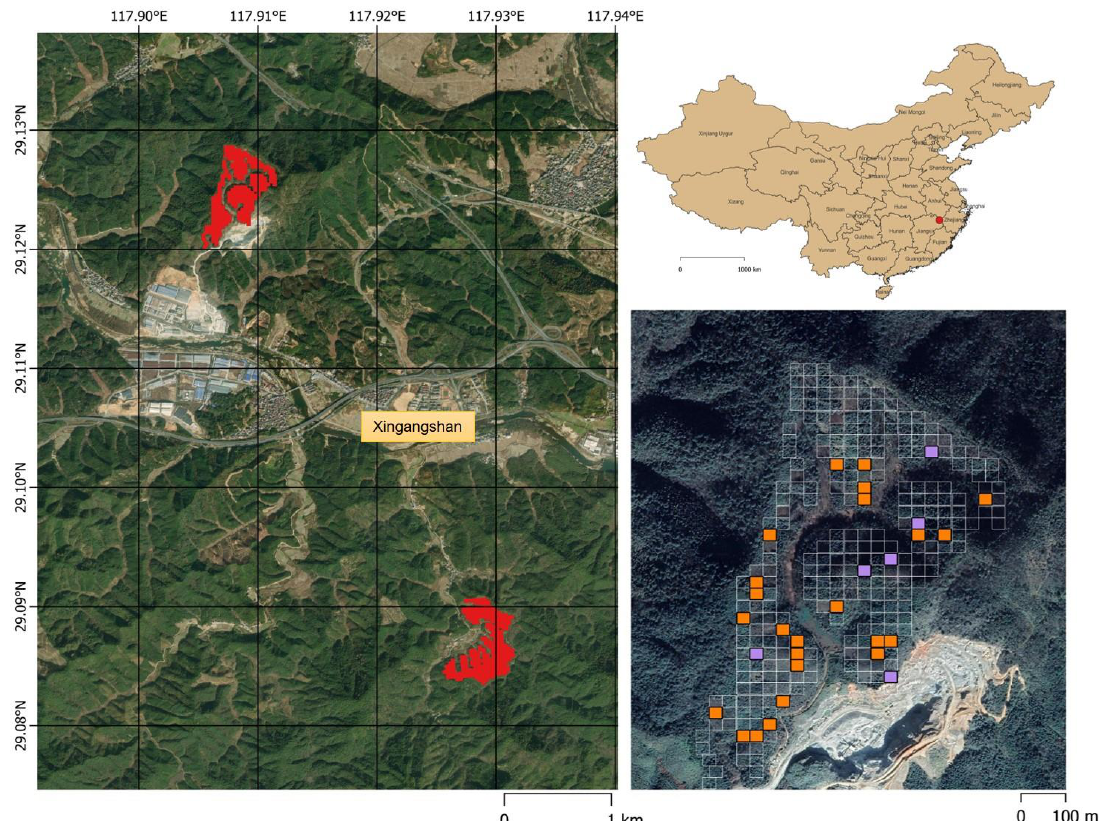
Figure 1. Location of the study site. The top right panel represents the provincial boundary of China, adapted from the Standford Geowebservice WFS (Hijmans, 2015). The location of the study area is represented with a red circle; the left panel shows the location of sites A and B (red polygons) and the closest village (Xingangshan), with the coordinates on the ESRI ArcGIS World Imagery WMS. The bottom right panel shows the studied plots on the ESRI ArcGIS World Imagery WMS: in orange monocultures and two-species mixtures, where nine scan positions were distributed following a regular grid, and in purple the four- and eight- species mixtures, where 16 scan positions were regularly distributed in the centre of the plot.